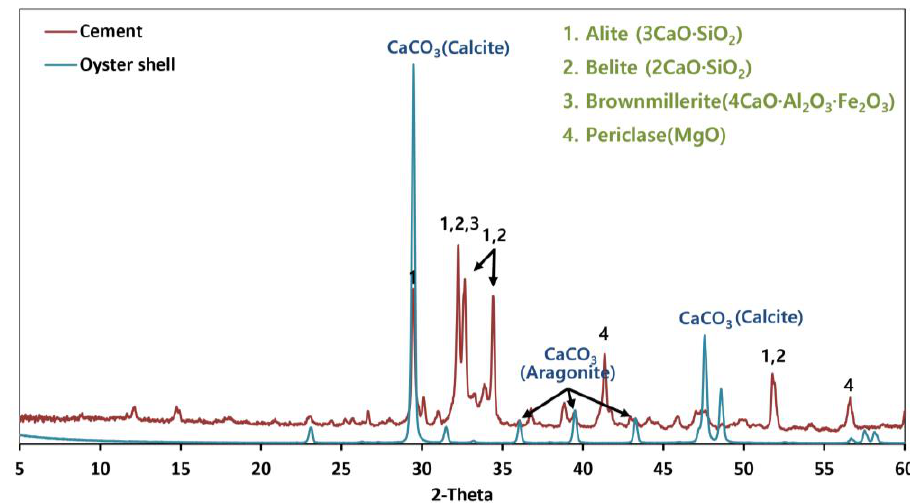
Figure 7. XRD of cement and the oyster shell aggregate. Figure 8. Structures of aragonite and calcite: ( a ) Aragonite; ( b ) Aragonite has a crystal structure; ( c ) In contrast, the crystal structure of calcite; ( d ) Calcium is octahedrally coordinated by O with site symmetry